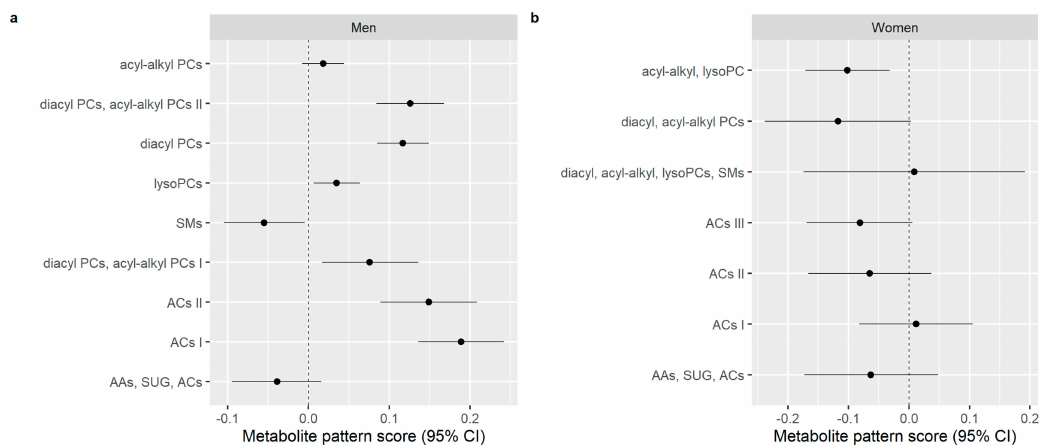
Figure 1. Associations between alcohol consumption in g / d and metabolite pattern scores at the time of recruitment (1994–1998) in EPIC-Potsdam; adjusted for age, sociodemographic and lifestyle factors, medications and chronic diseases-related medication. Changes in metabolite patterns scores with increased 12-g intake of alcohol per day in ( a ) men and ( b ) women; Abbreviation: AAs, SUG, ACs, Amino acids, sugar and free and short chain acylcarnitines, respectively; ACs I, Long and short chain acylcarnitines; ACs II, Medium and long chain acylcarnitines; ACs III, Short and medium chain acylcarnitines; acyl-alkyl, lysoPC, Acyl-alkyl- and lyso-phosphatidylcholine; diacyl, acyl-alkyl PCs, Diacyl- and acyl-alkyl-phosphatidylcholine; diacyl, acyl-alkyl, lysoPCs, SMs, Diacyl-, acyl-alkyl-, lyso- phosphatidylcholines and